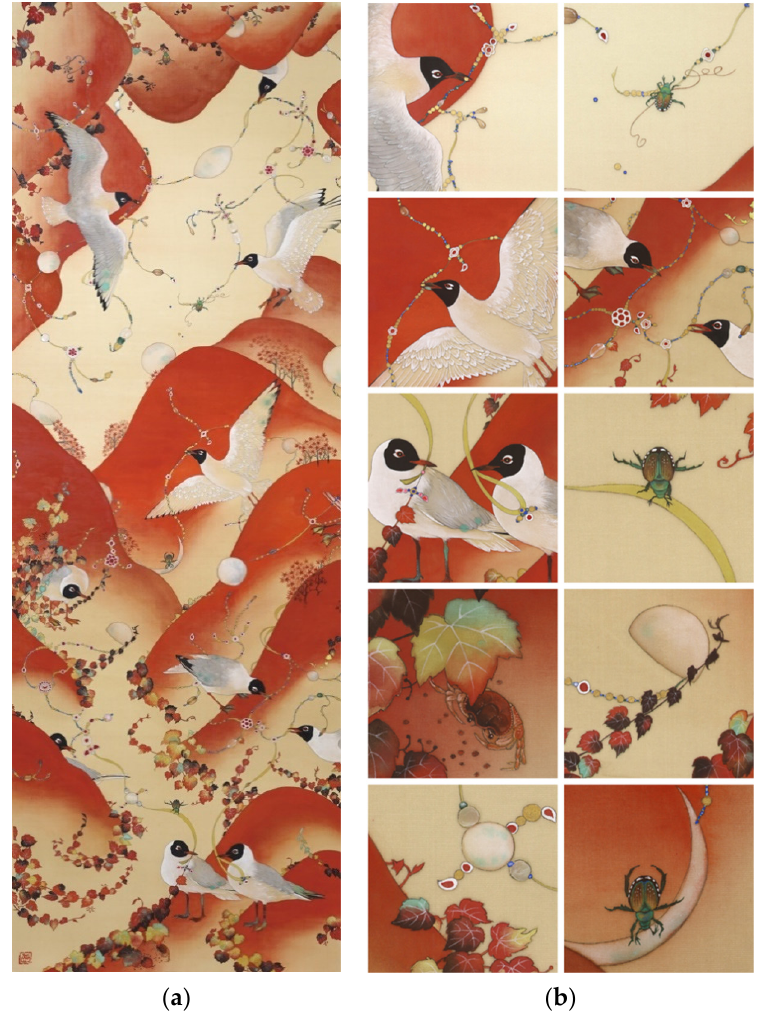
Figure 5. ( a ) NAKAMURA Kyoko, “ Wait for Flower-Folding Bird s”, color on silk, hanging scroll, 153 × 50 cm, 2018.; ( b ) Detail of painting. Painting mounted by S ō gad ō , Tokyo, Japan.